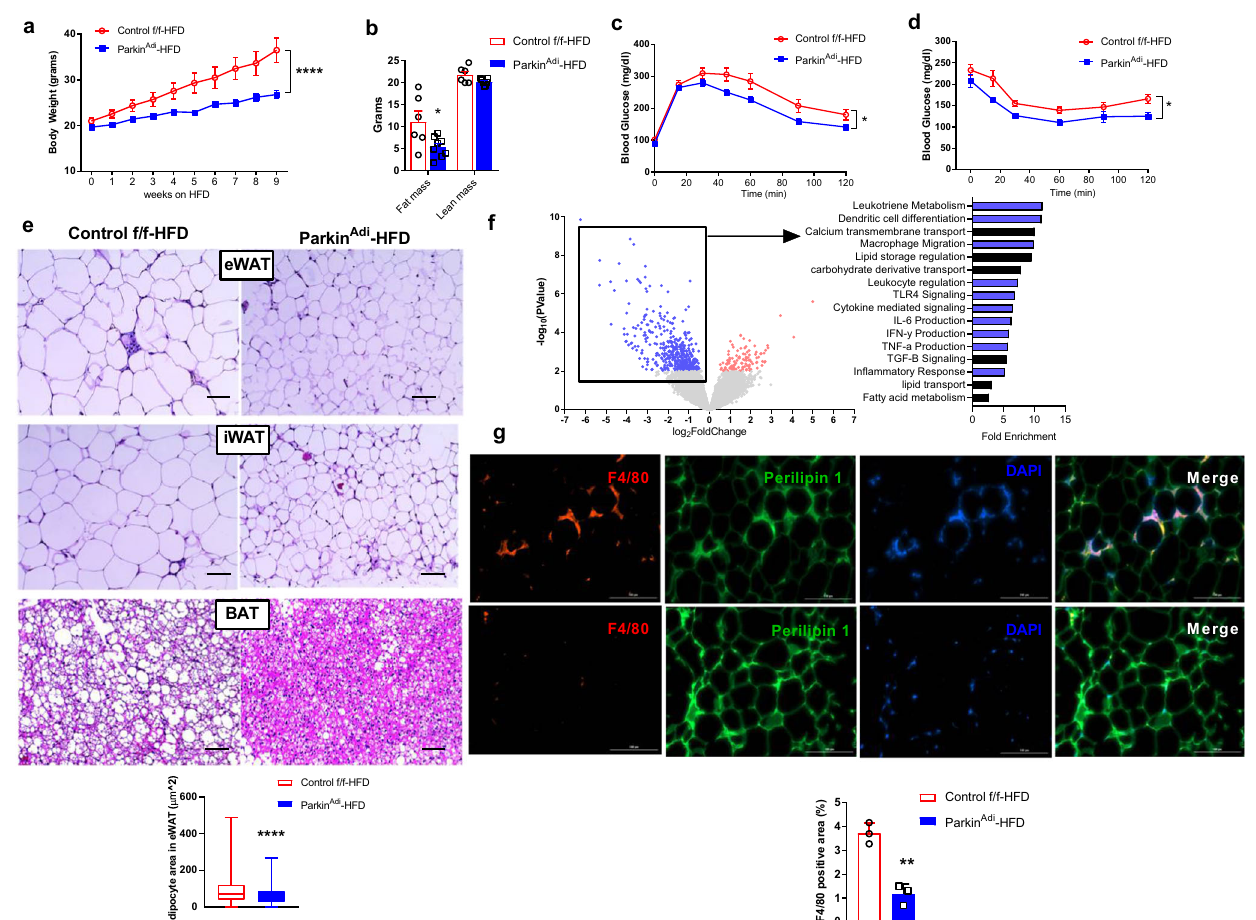
Fig. 2 | Adipose-speci fi c deletionofParkin ameliorateshigh-fatdietand aging- inducedobesityandglucosetolerance.a BodyweightofHFD-fedControlf/fand Parkin Adi mice ( n =8 mice per genotype) [Two-way ANOVA F(1,14)=29.51, p <0.0001, 95%CI=3.887 – 6.236]. b Body consumption of Control f/f and Parkin Adi mice following a 9-week HFD ( n =6 mice for Control f/f group, n =8 mice for Parkin Adi group) [Unpaired Student ’ s t test two-tailed. For fat mass Control f/f-HFD vs. Parkin Adi -HFD, p =0.0246, 95%CI= − 10.68 to − 0.8768, R squared=0.3547]. c Glucosetoleranceteston6weeksof HFD-fed Controlf/fandParkin Adi mice( n =7 mice per genotype) [Two-way ANOVA F(1,12)=6.477, p =0.0257, 95% CI=5.134 – 66.21]. d Insulin tolerance test on 7 weeks of HFD-fed Control f/f and Parkin Adi mice ( n =5 mice per genotype) [Two-way ANOVA F(1,8)=7.594, p =0.0248,95%CI=5.337 – 60.06]. e H&E-stained sections ofeWAT,